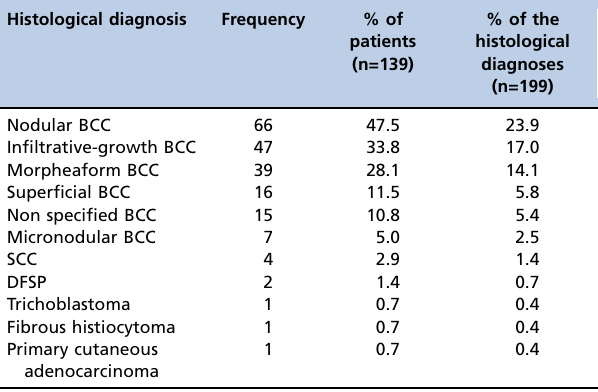
Table 3 - Descriptive statistics by histological diagnosis.